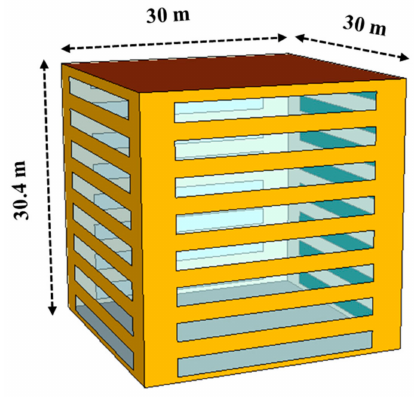
Figure 4. 3D modeling of the o ffi ce building.